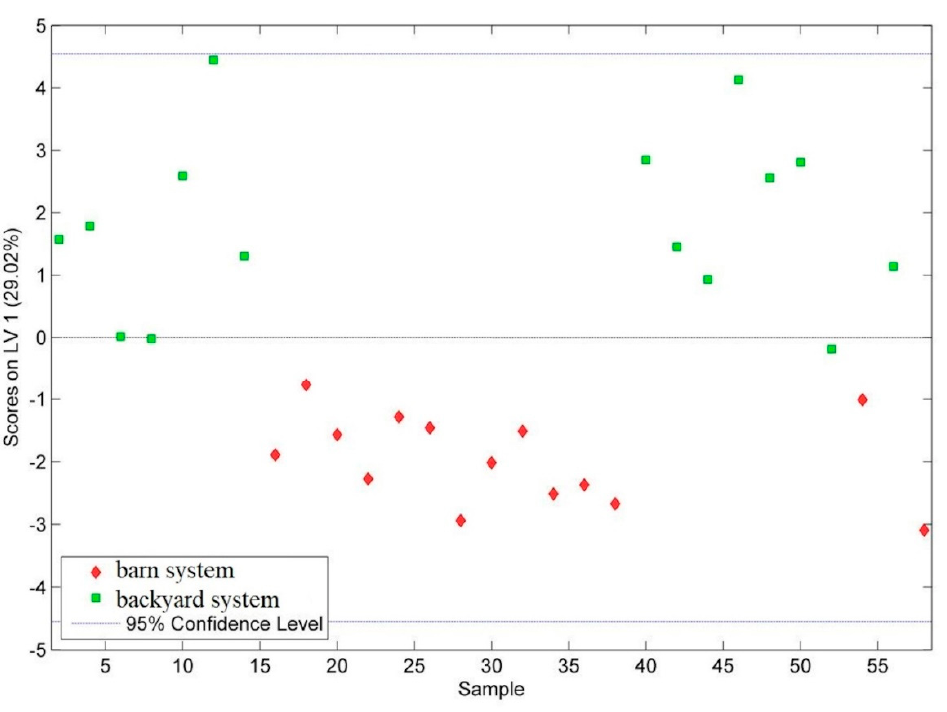
Figure 3. PLS–DA score plot associated to the classification of the egg yolk samples with respect to the hen growing system.